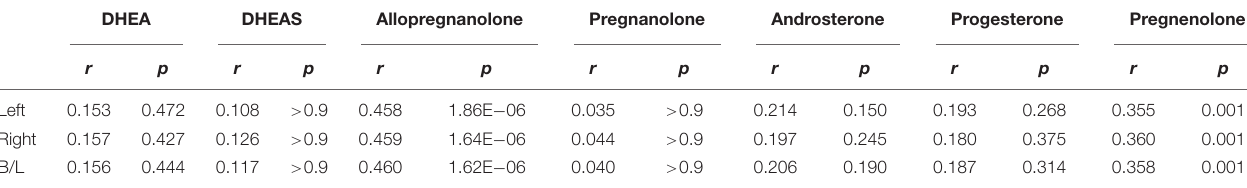
TABLE 2 | Neurosteroid associations with global gray matter volume by